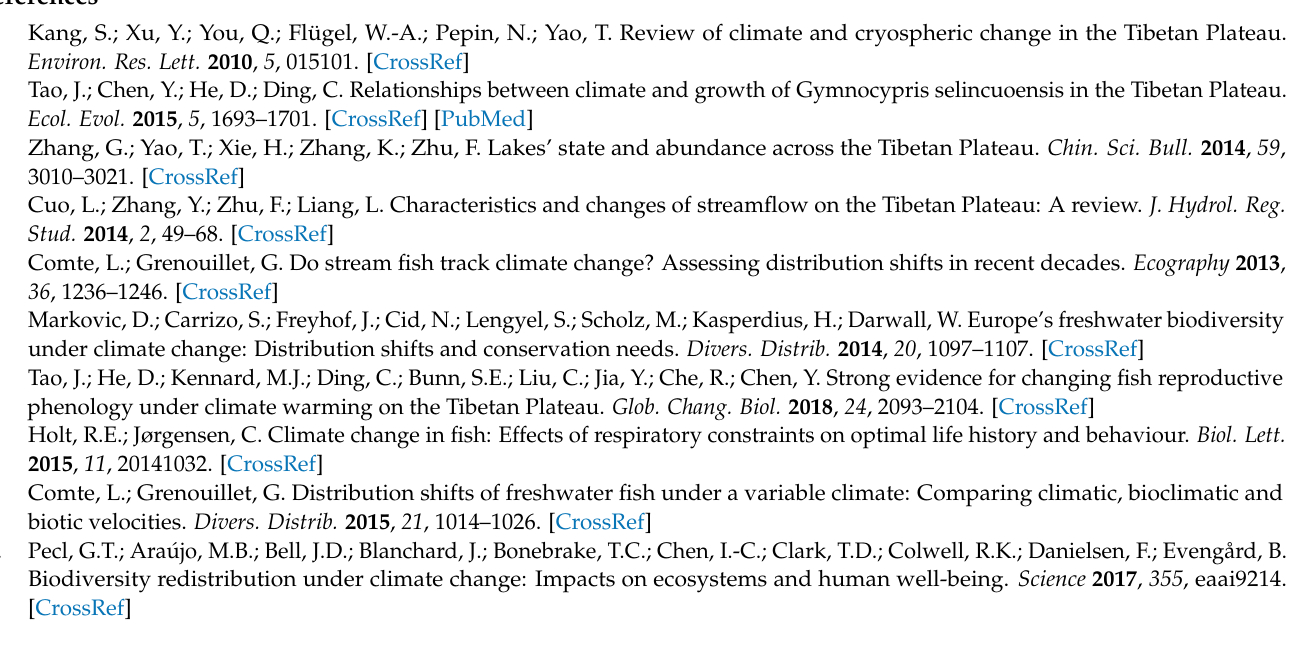
(ROC) curve verification of distribution of Glyptosternon maculatum (a), Oxygymnocypris stewartii (b) and Gymnocypris selincuoensis (c) under different climate scenarios predicted by the Maxent model. Figure S2: Results of Jackknife tests of regularized training gain for the contribution of variables for G. maculatum (a), O. stewartii (b) and G. selincuoensis (c) under different climate scenarios predicted by the Maxent